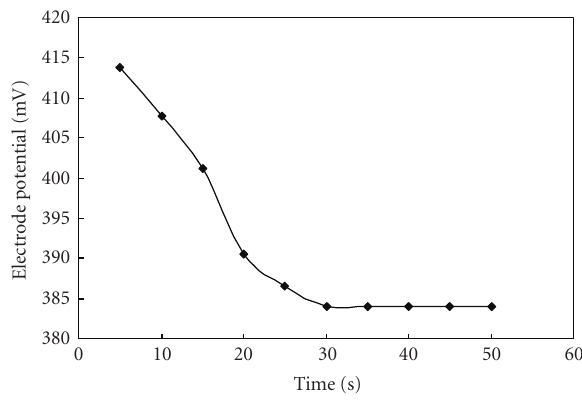
Figure 8: Time response curve of poly-o-anisidine Sn(IV) arsenophosphate membrane electrode.